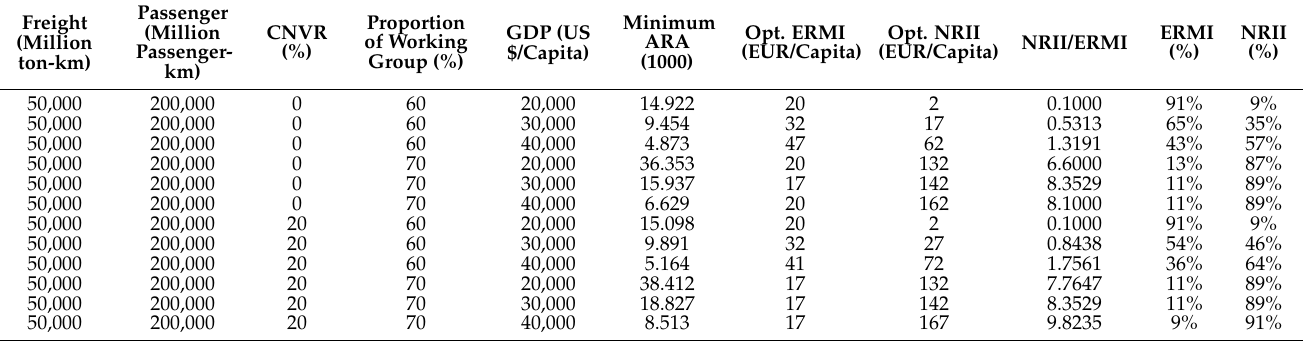
Table 6. Sample-minimized ARA and the corresponding NRII/capita and EMRII/capita for popula- tion of 10